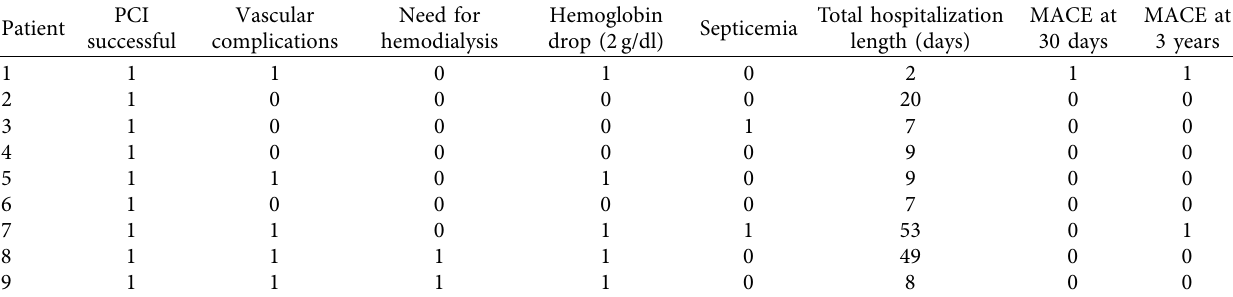
Table 4: Clinical